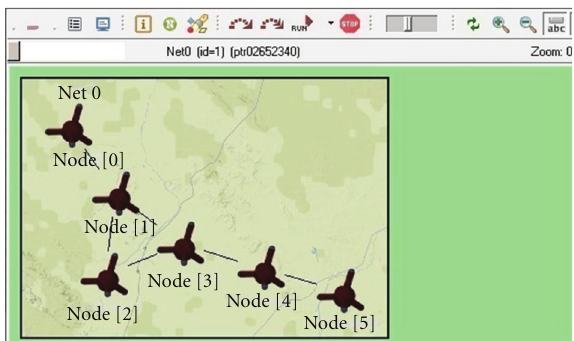
Figure 7: Network topology—A screenshot with fixed nodes.